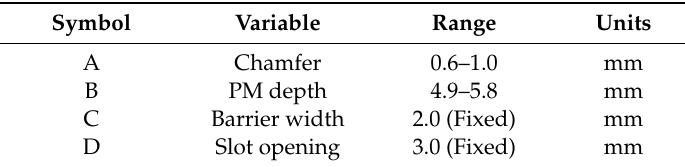
Table 3. Ranges of design variables for FFD.